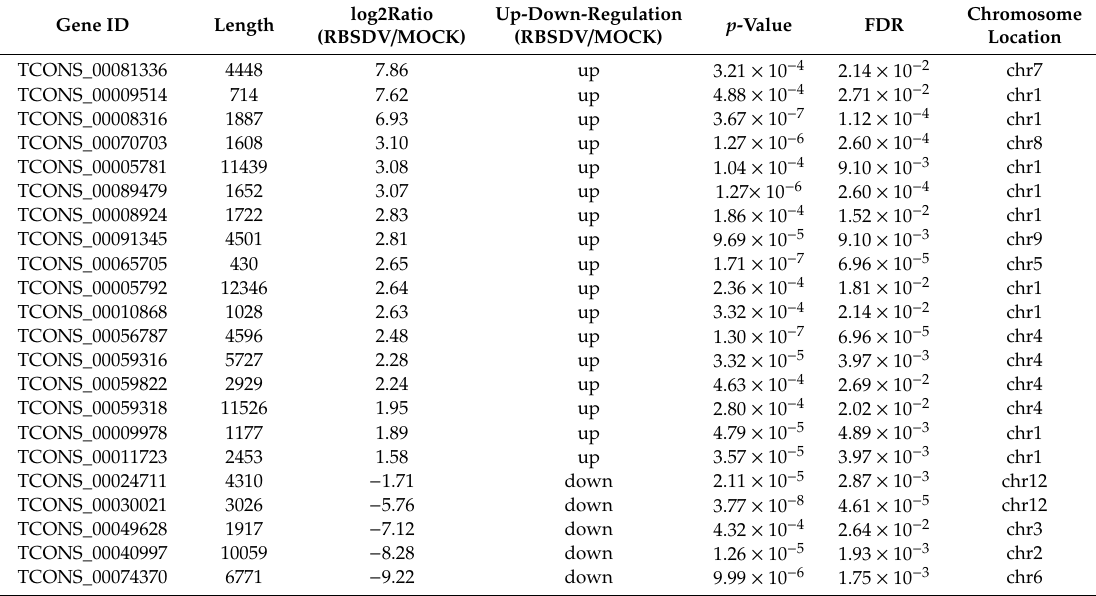
Table 2. Identified di ff erentially expressed long non-coding RNAs (lncRNAs) (DElncRNAs) in the Rice black-streaked dwarf virus (RBSDV)-infected rice